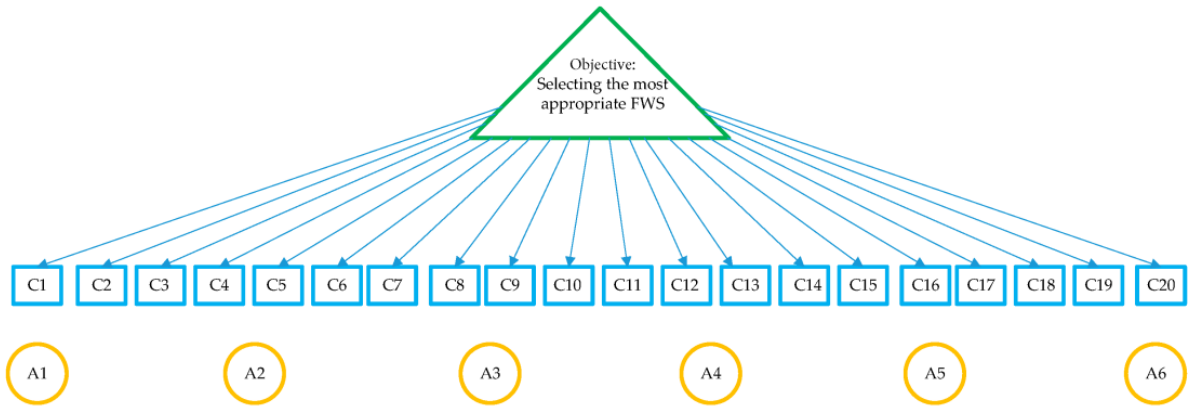
Figure 4. Final decision hierarchy for the case study.